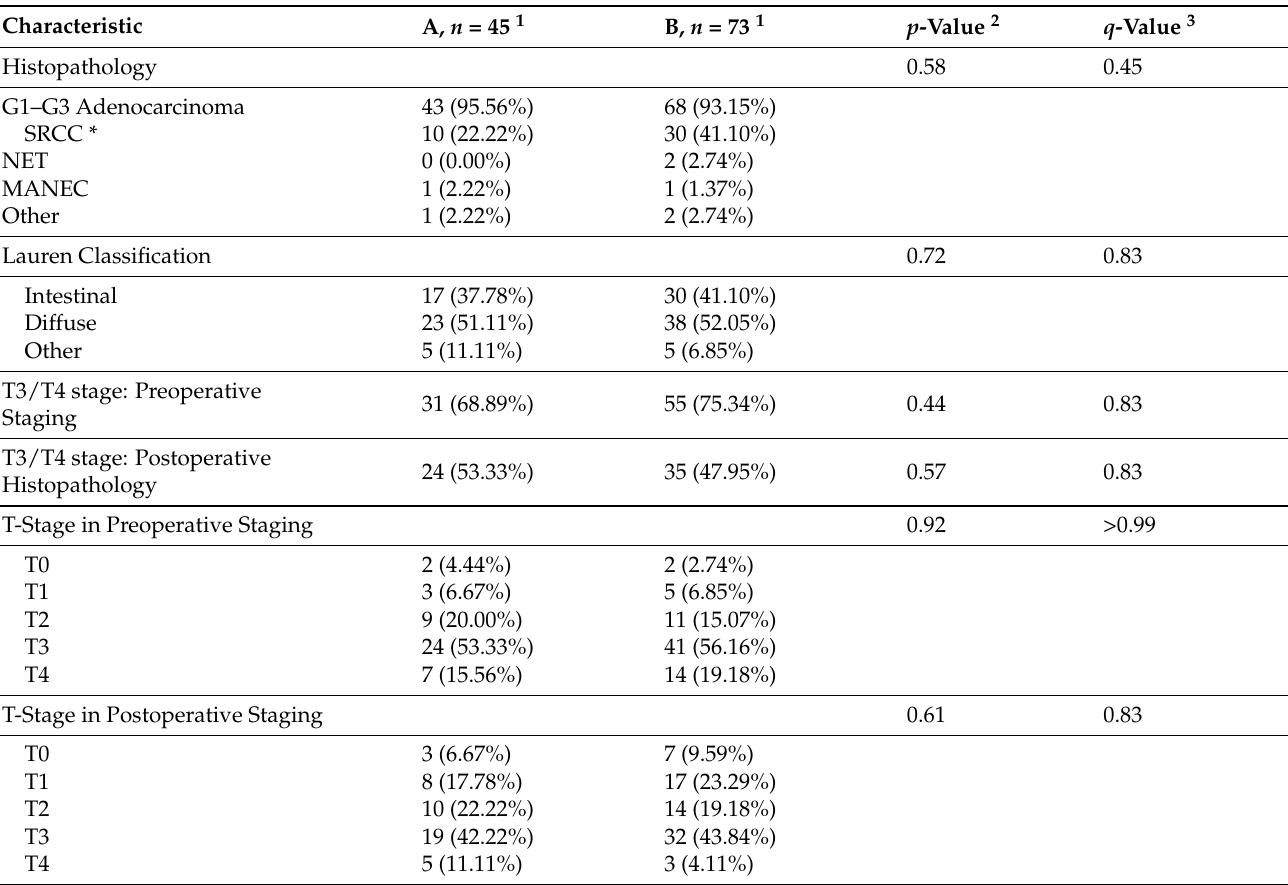
Table 2. Histopathological